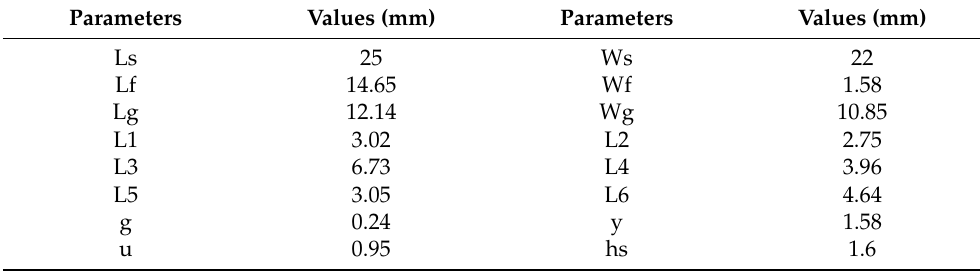
Table 2. Different design parameters of the presented